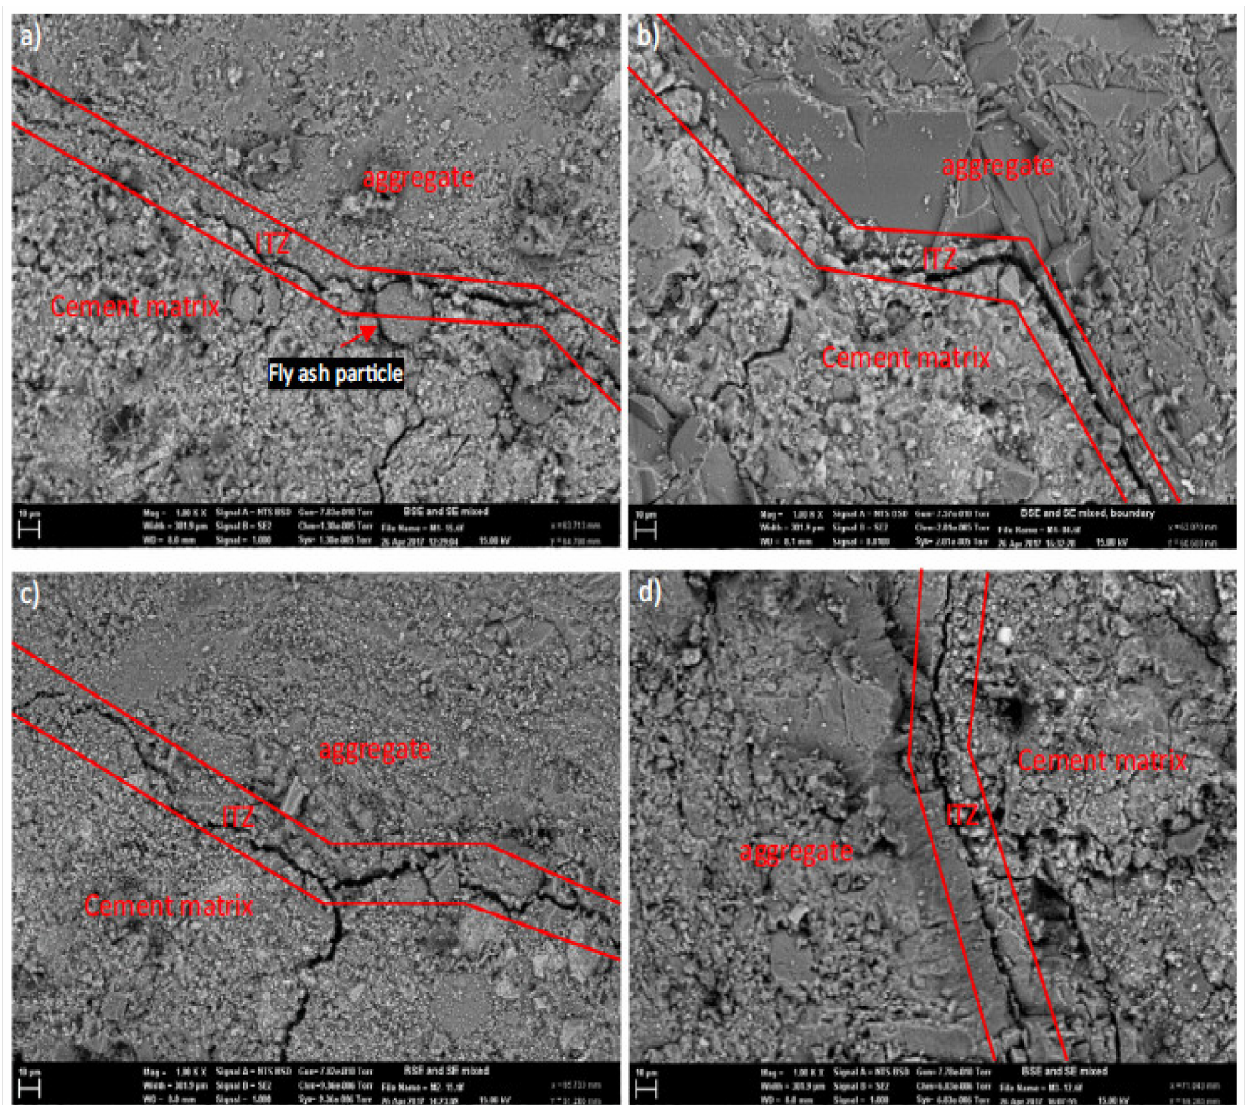
Figure 19. Interfacial Transition Zone (ITZ): As per Elsevier Permission [48]. ( a ) 0% ( b ) 12.5% ( c ) 25% and ( d ) 50%